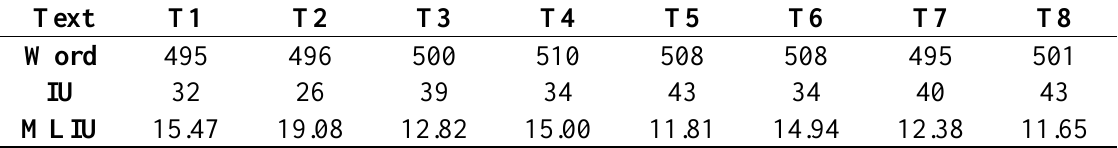
Number and Mean Length of Idea Units